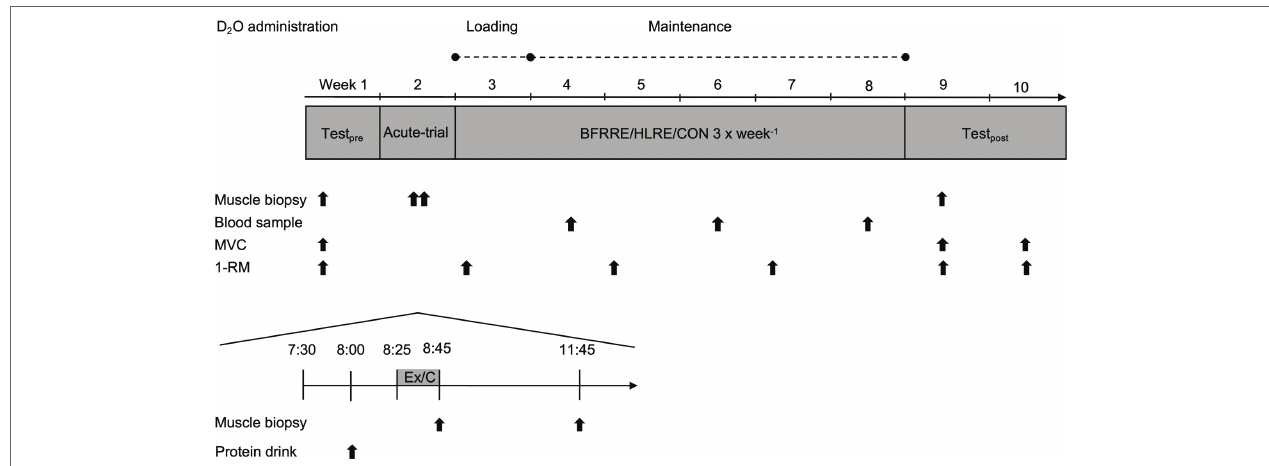
FIGURE 1 | Study overview. Pre-test was conducted 2 weeks prior to the 6-week training period. MVC maximal voluntary contraction; 1-RM one-repetition maximum; Ex, exercise; C,